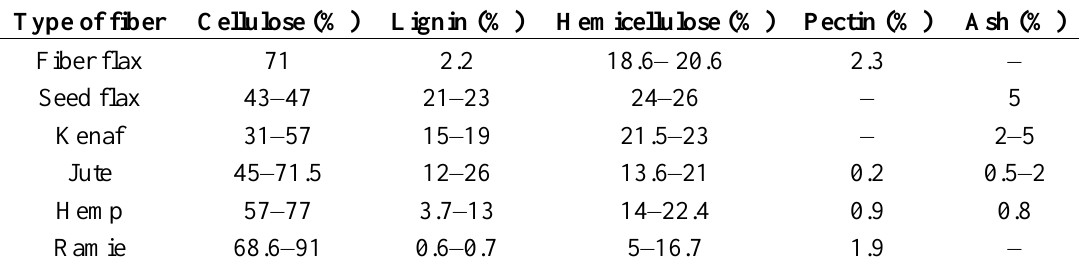
Table 1. Chemical composition of selected natural